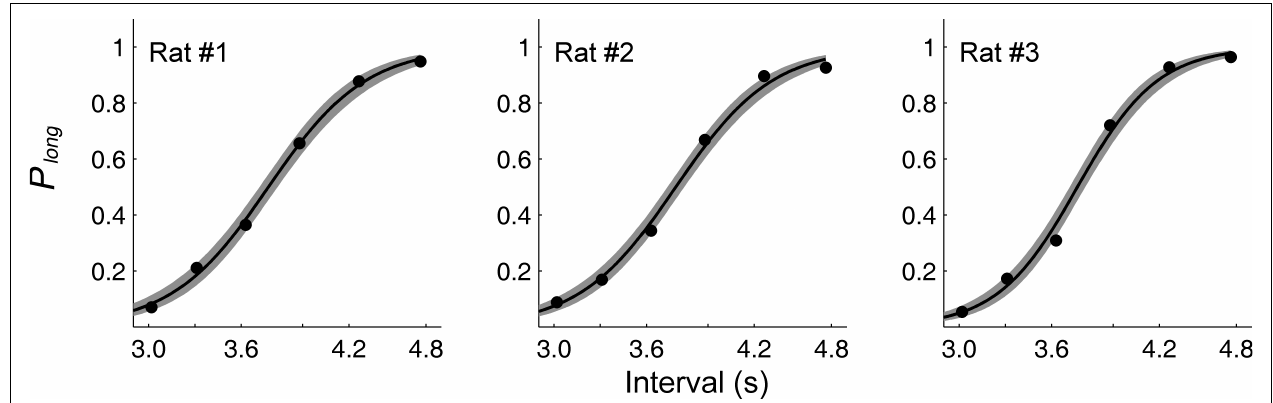
FIGURE 3 | Choice behavior in the random-trial task. The graphs show the proportion of long-target choices ( P behavioral sessions for each non-operated animal (experiment 1). The solid lines were determined by logistic regression and the shading indicates 95% confi dence interval.